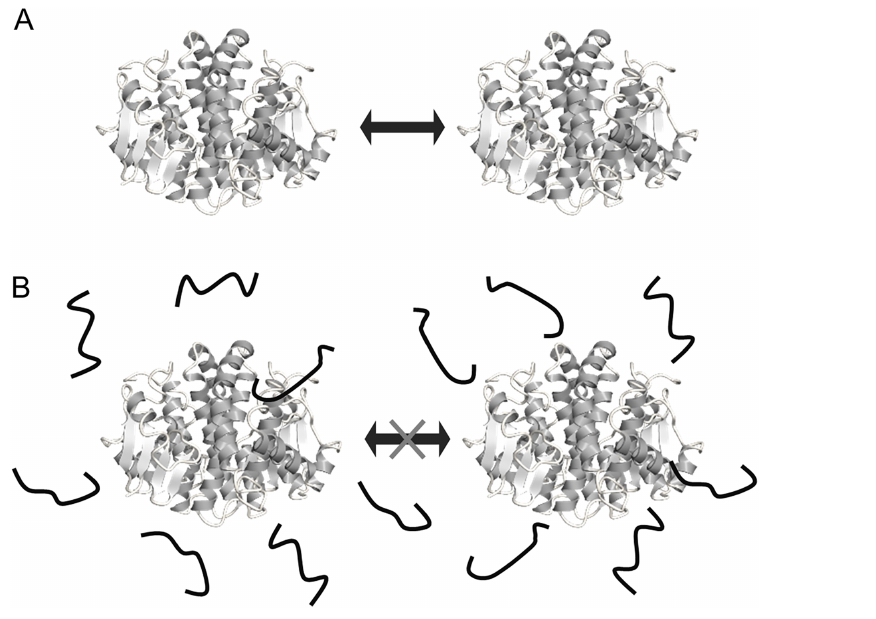
Figure 6 Schematic representation of the mechanisms for cryoprotection of enzyme by FK20. (A) Illustration of the mechanism of stochastic protein collisions upon repeated freeze/thaw cycles. The GST molecule (dimer) is represented by the ribbon diagram. The fi lled block arrow indicates stochastic direct collision of proteins during freeze/thaw cycles. (B) Illustration of the molecular shield model of FK20 cryoprotective activity toward the enzymes, originally proposed by Chakrabortee et al. (see text) ( Chakrabortee et al., 2012 ). FK20 is represented as bold